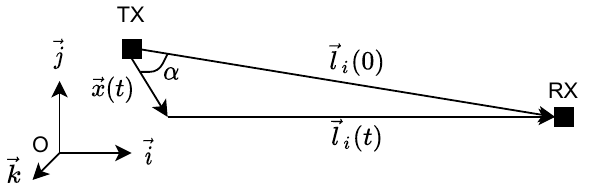
Figure 1. Geometrical